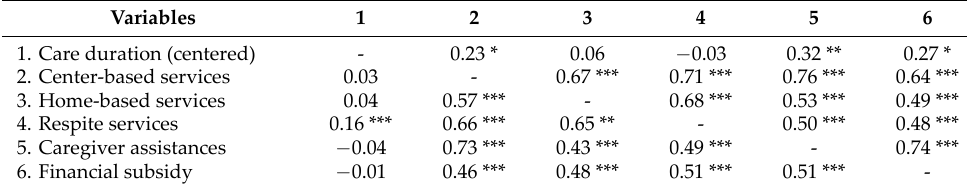
Table 2. Correlation matrices ( n = 702).